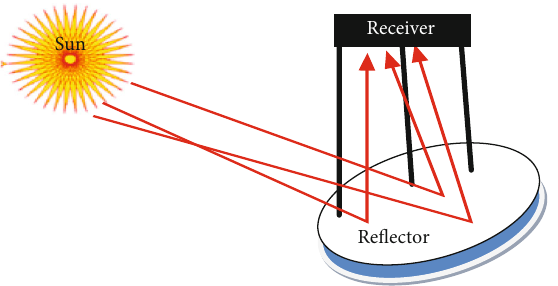
Figure 6: A diagram of the parabolic dish